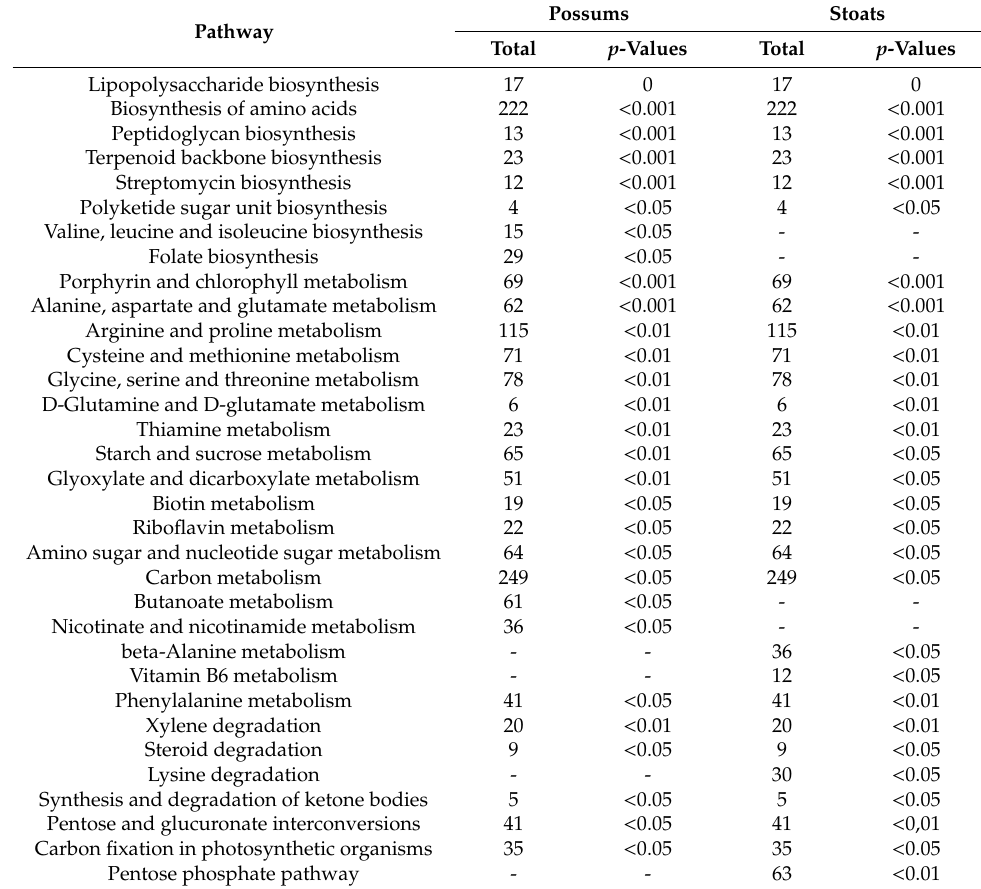
Table 2. Functional enrichment of biochemical pathways identified from the oral microbiota of brushtail possums and stoats (names, total number of pathways and p